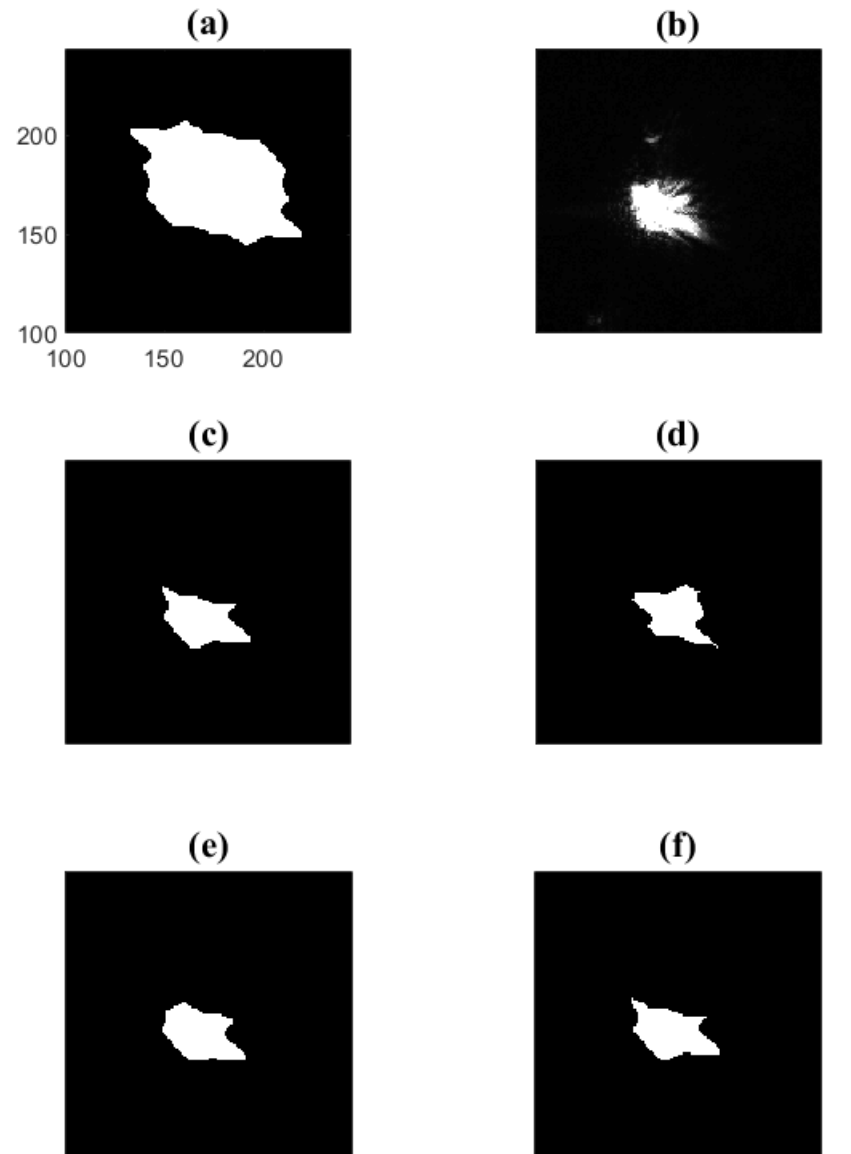
Figure 5. Binarized 2D-Fourier transform of the IPI image of an ice particle in the tunnel ( a ) (axes are in pixels, 5.5 µm per pixel). Four possible shapes deduced by the tri-intersection method, whose 2D-autocorrelations approximately match the contours in figure ( a , c – f ), and an in-focus image of the real particle recorded simultaneously with a second CCD sensor ( b ) (same scale for all subfig- ures).